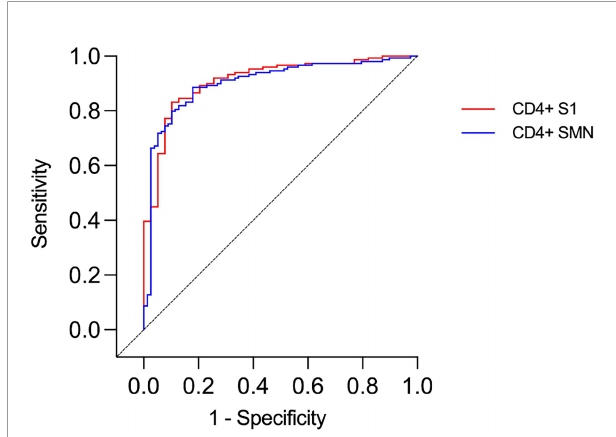
FIGURE 5 | ROC curves presenting results from CD4 + T cell assays in health care workers with and without veri fi ed infection. Identity line (diagonal).